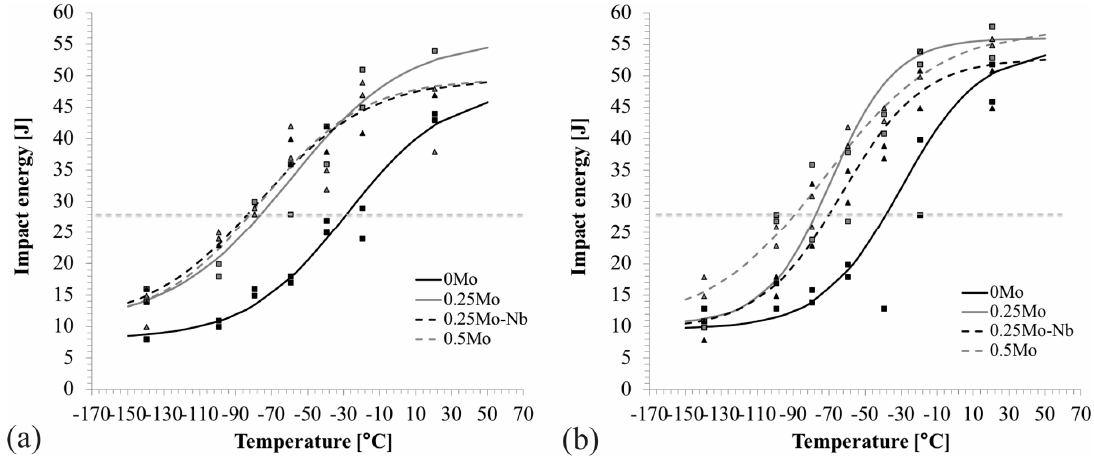
Figure 8. Transition curves in longitudinal direction for the as-quenched specimens: ( a ) FRT 800 °C, and ( b ) FRT 900 °C.